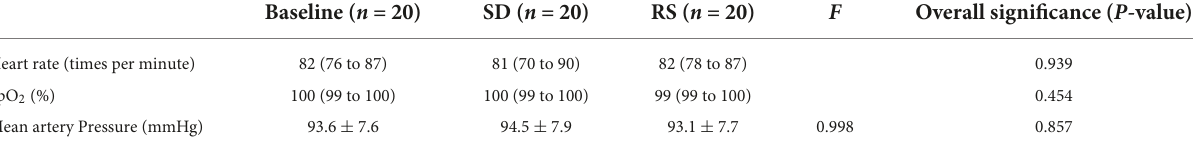
TABLE 1 Participants’ vital signs.